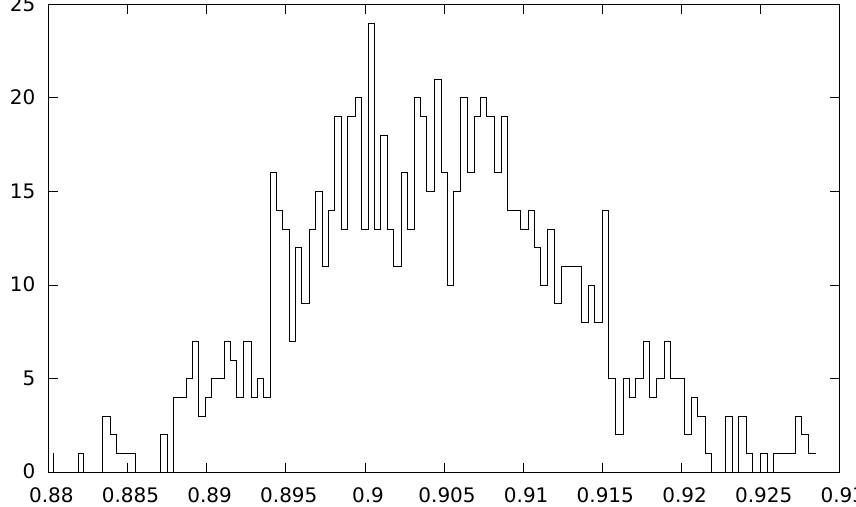
Figure 5. Number of samples with a similar percentual deviation from common